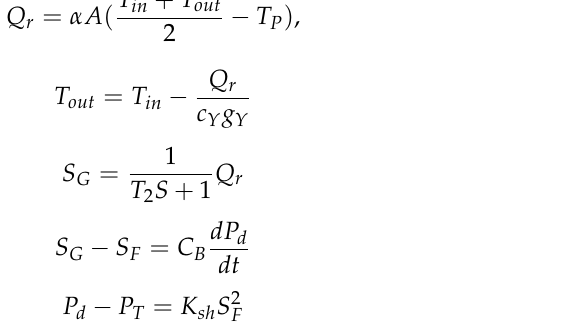
Figure 5. Reheat system model. 3.2. Fault Setting The fault characteristics, that is, the amplitude and period of the oscillating load mu- tation and the amplitude and duration of the pulsing load mutation, can be extracted from the fault analysis in Section 2. As shown in Figure 6, the fault characteristics obtained from Section 2 can be used as the fault data of the single-shaft CCPP with open-loop regulation. The data with these faults of the CCPP can be obtained through the dynamic model of the single-shaft CCPP established in Section 3. More specifically, the fault characteristics ex- tracted in Section 2 are superimposed on the power output of the thermal system, which is regarded as the input entering the load controller and participating in the closed-loop control of the CCPP model. All parameters used in this section except time are per unit value (p.u.). Figure 6. Fault simulation model of single-shaft CCPP.